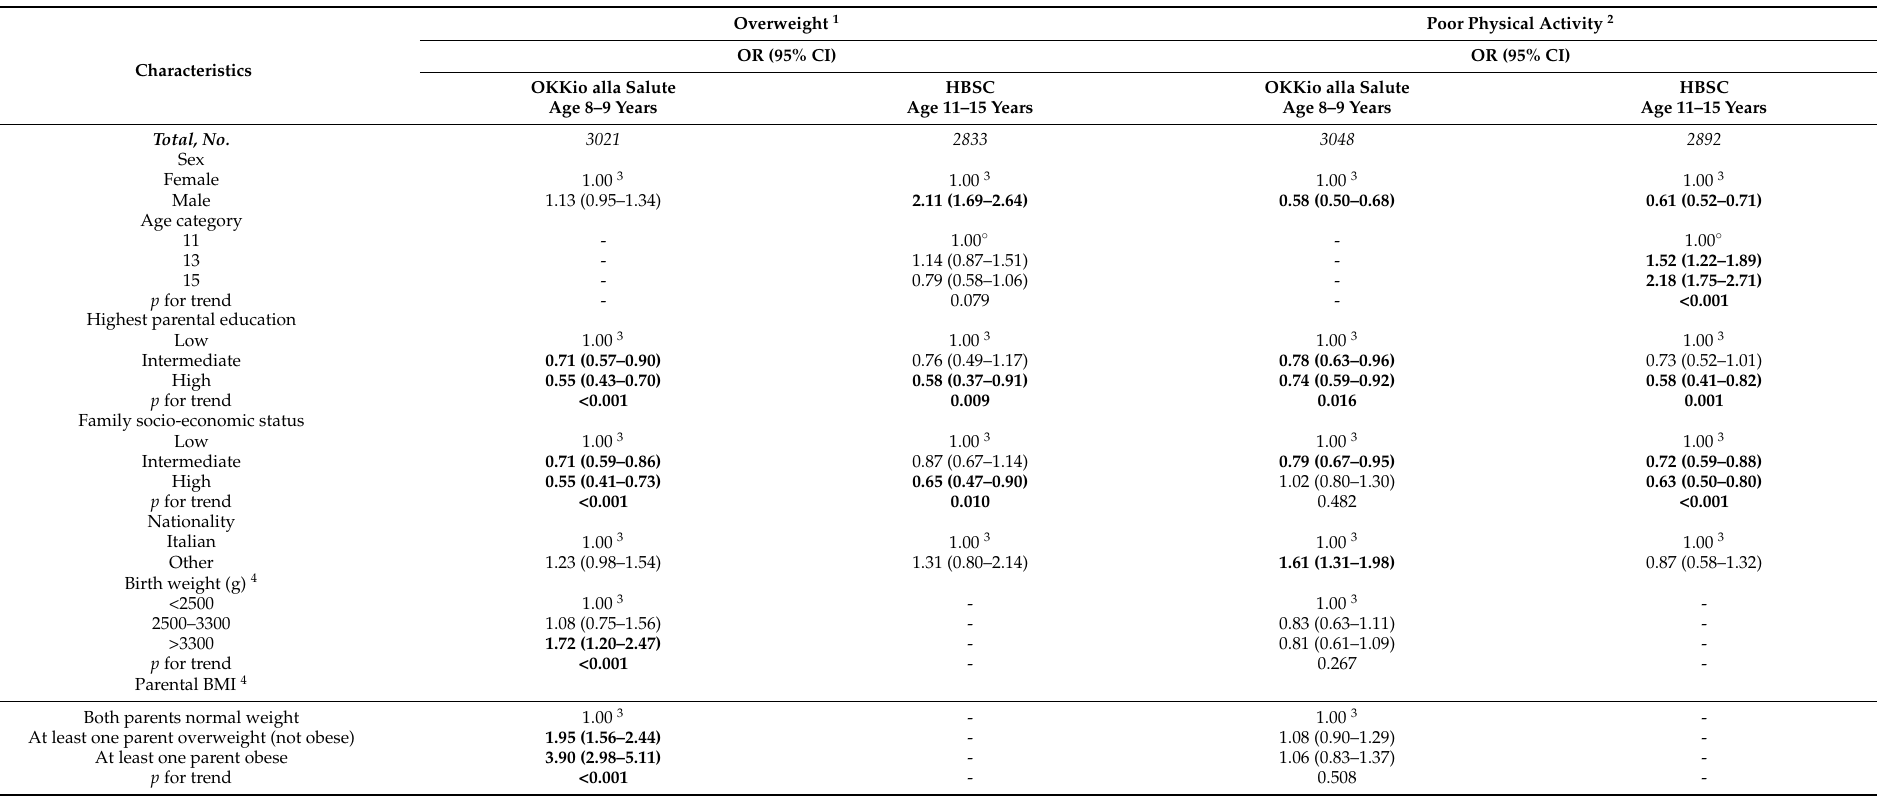
Table 2. Odds ratios (OR) and corresponding 95% confidence intervals (CI) for childhood overweight (including obesity) and poor physical activity according to selected socio-demographic and family characteristics. Lombardy,